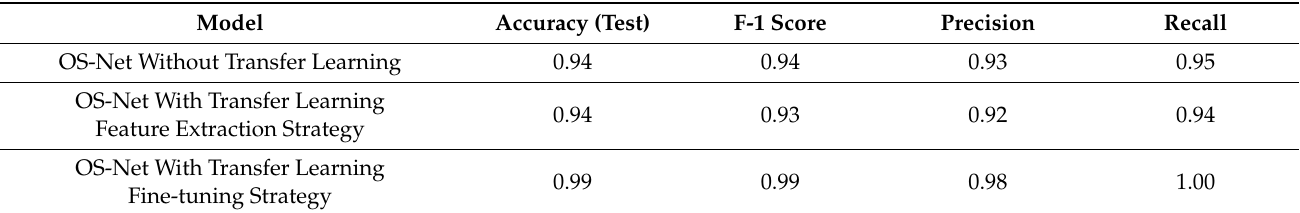
Table 1. Model evaluation